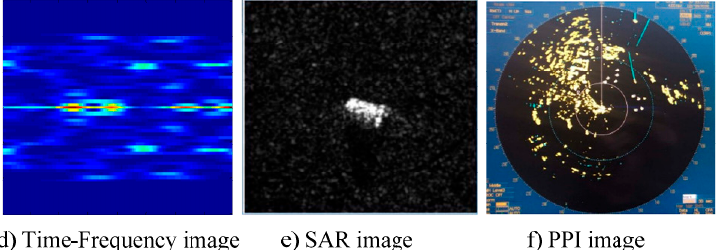
Figure 10. Input type of multiple CNN-based detectors, ( a ) Radar received echo; ( b ) Range-Doppler spectrum; ( c ) Pulse-Range image; ( d ) Time-Frequency image; ( e ) SAR image; ( f ) PPI image.